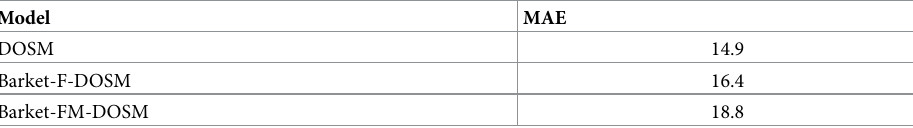
Table 8. Comparison between models by MAE value (in